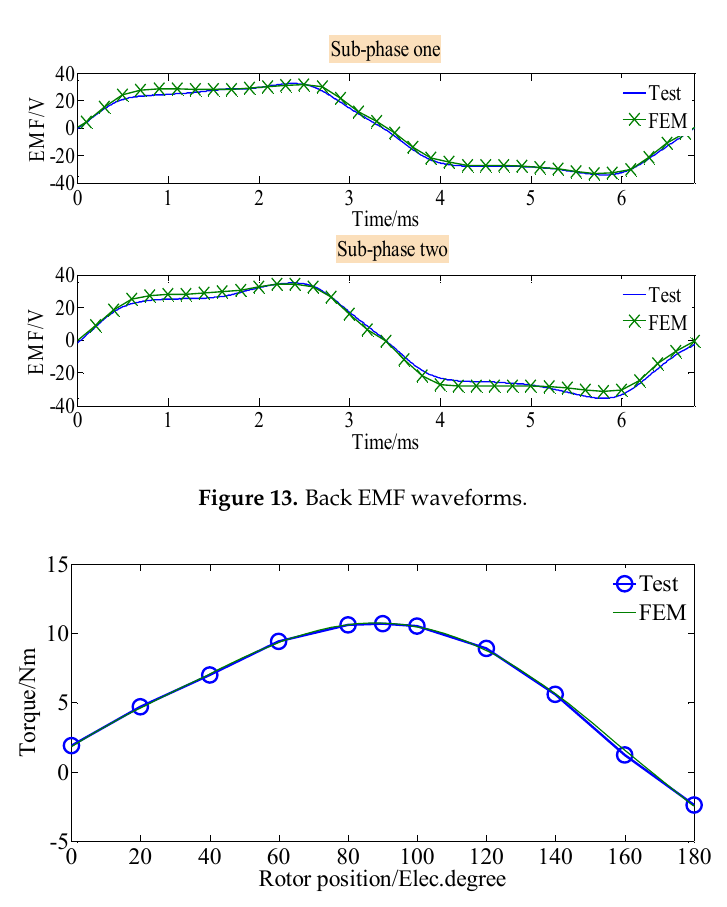
Figure 14. Stationary torque waveforms.